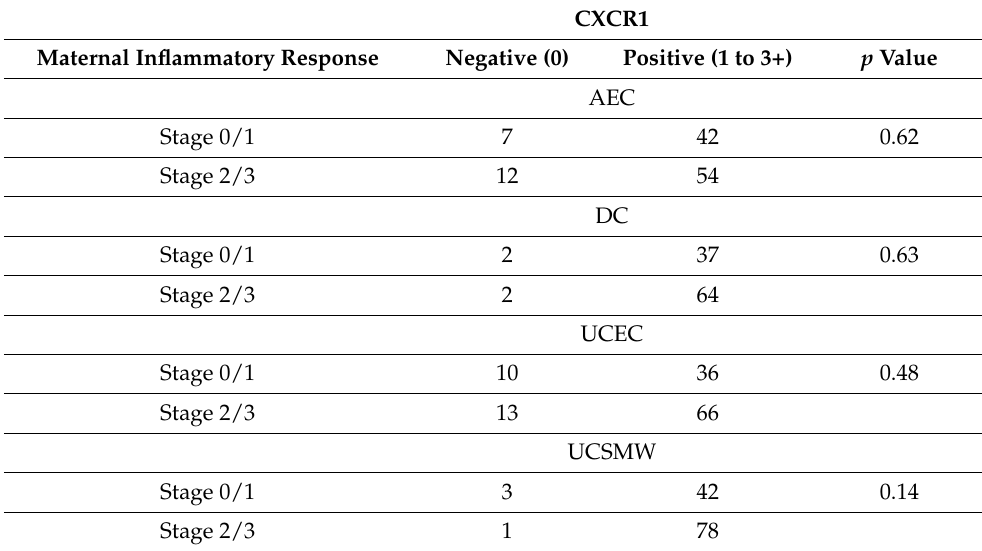
Table 3. Comparison of CXCR1 expression at different stages of maternal inflammatory response in cases with